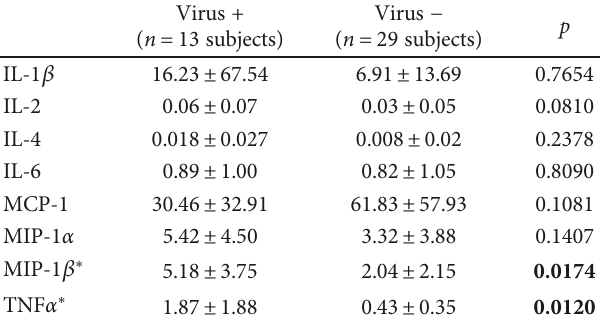
Table 4: Comparison of salivary marker concentration (mean ± standard deviation) between positive (+) and negative ( − )